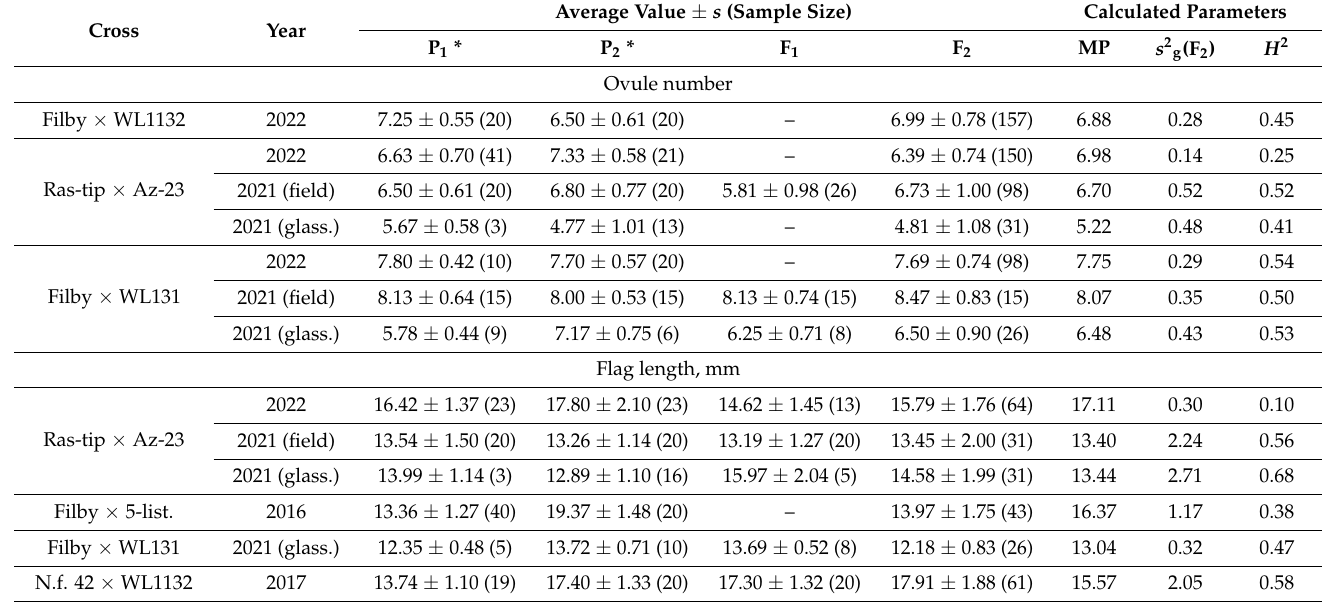
Table 2. Values and derived parameters for hybrid progenies and corresponding parental